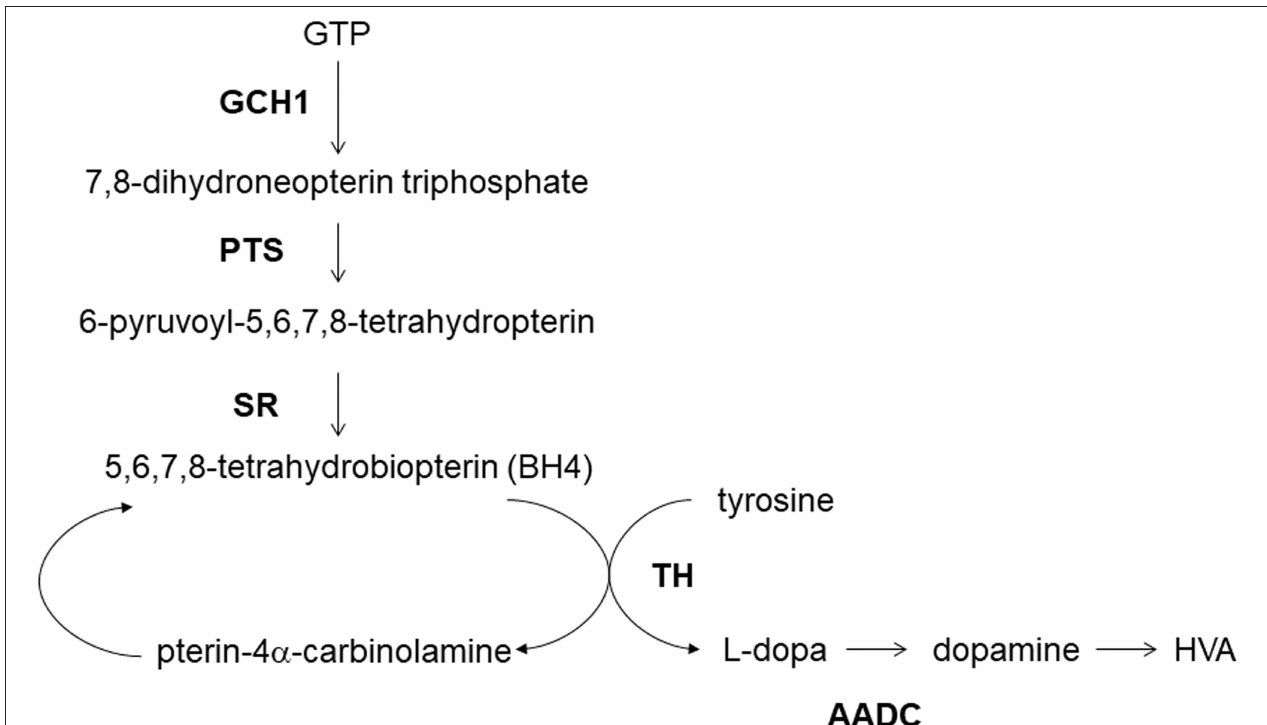
FIGURE 1 | Dopamine metabolism and GCH1. GCH1, GTP cyclohydrolase 1; PTS, 6-pyruvoyltetrahydropterin synthase; SR, sepiapterin reductase; TH, tyrosine hydroxylase; AADC, aromatic L-amino acid decarboxylase; HVA, homovanillic acid.